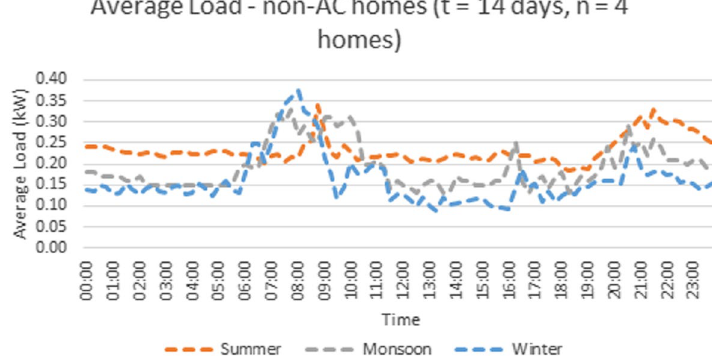
Fig. 12 Comparison of the current consumption of AC homes for Summer, Winter, and Monsoon